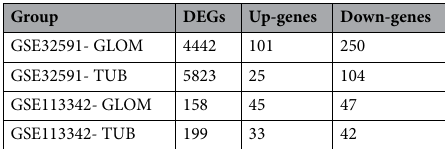
Table 2. Differentially expressed gene.